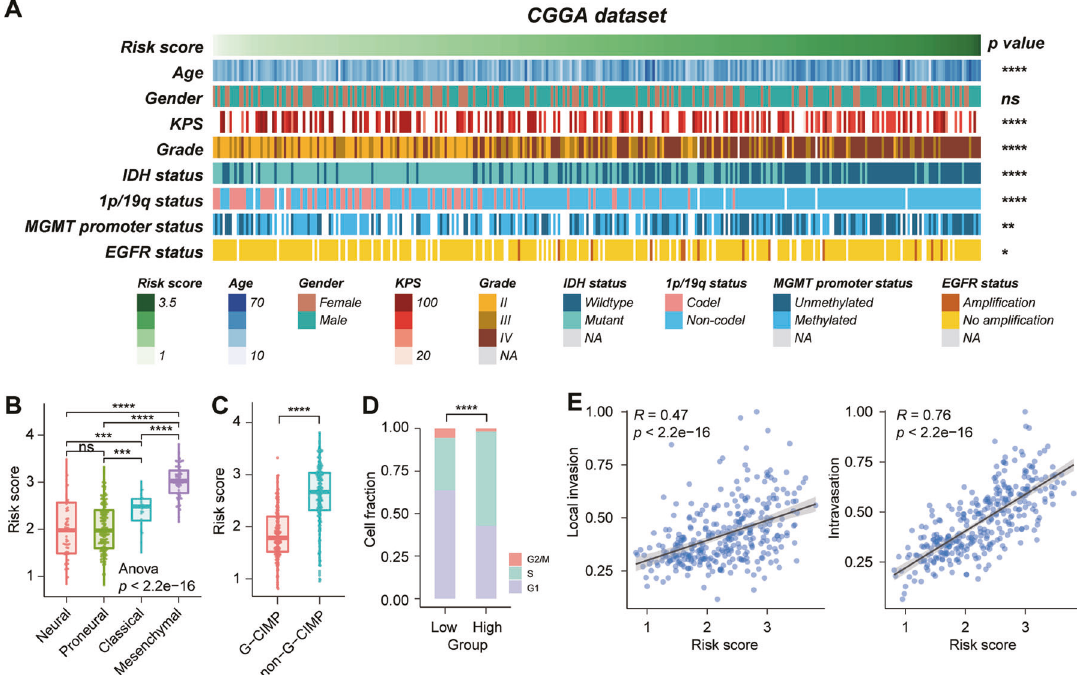
Fig. 2 Relationship between the signature risk score and the pathological characteristics in the CGGA dataset. A The distribution of clinical and pathological characteristics arranged by the increasing risk score. B , C Distribution of risk score in patients strati fi ed by TCGA subtype and G-CIMP subtype. D The relationship between risk score and cell-cycle proportion in the CGGA dataset. E The correlation between risk score and invasion index was analyzed by Pearson correlation analysis. **** p < 0.0001; *** p < 0.001; ** p < 0.01; * p < 0.05; n.s. no signi fi